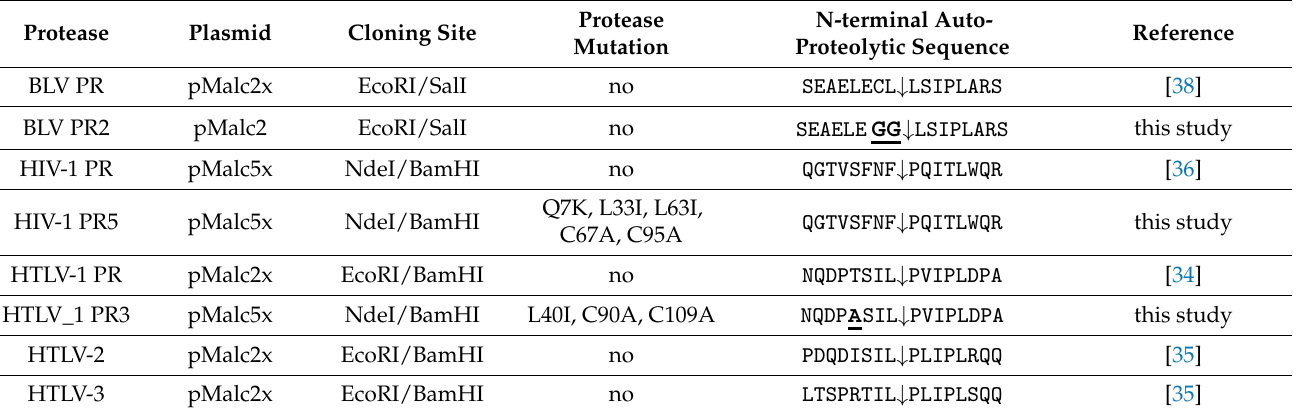
Table 1. Expression constructs. The recombinant proteins expressed from the plasmids contained an N-terminal MBP fusion tag, the protease was connected to this tag via an 8 residue-long linker representing the natural cleavage site of the given protease. The arrows indicate cleavage position within the autoproteolytic cleavage site sequences. Cleavage site mutations are bold and underlined.